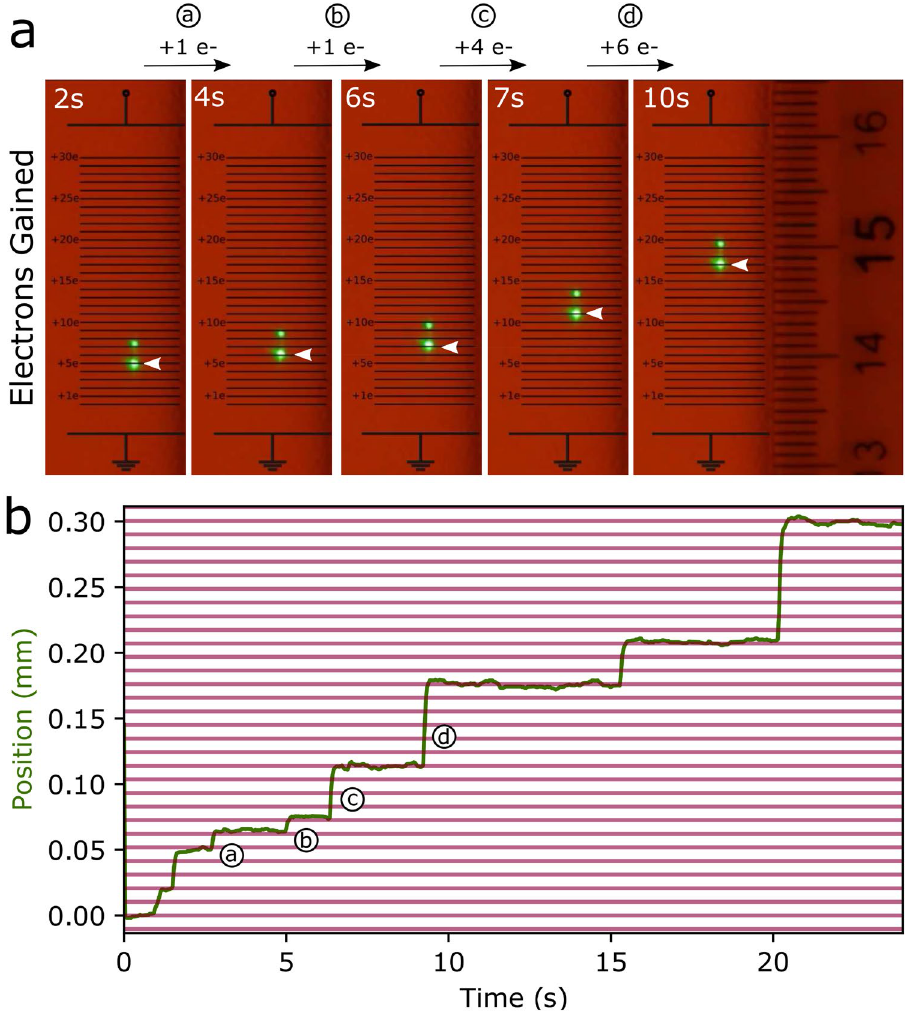
Figure 2. Visibly quantized steps of a levitated droplet as it gains electrons. ( a ) Screenshots of the droplet’s projection on the wall before and after steps a (+ 1e), b (+ 1e), c (+ 4e) and d (+ 6e). Black horizontal lines mark the displacement caused by a single electron addition and are set to the lower bright image of the droplet. The last image to the right shows a mm ruler that had been attached to the wall. ( b ) Real displacement of the droplet (green) calculated from the video of the displacement on the wall.